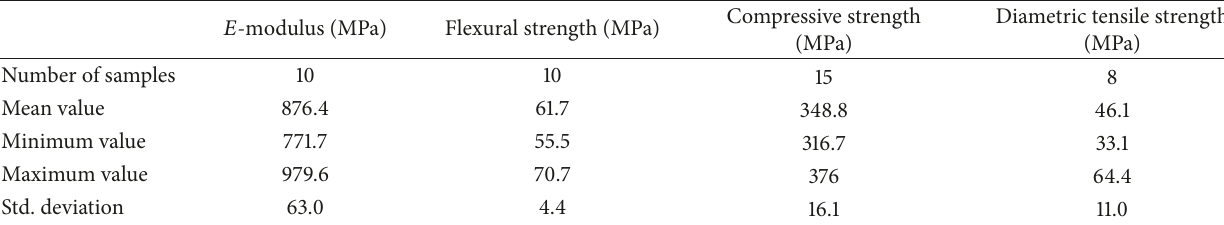
Table 1: Mechanical properties of the photocured resins at 1.4mW/cm 2 light intensity, with an irradiation time of 30 seconds. The sample size is denoted by 𝑛 . We used IBM SPSS Statistics Version 22 for all statistical calculations